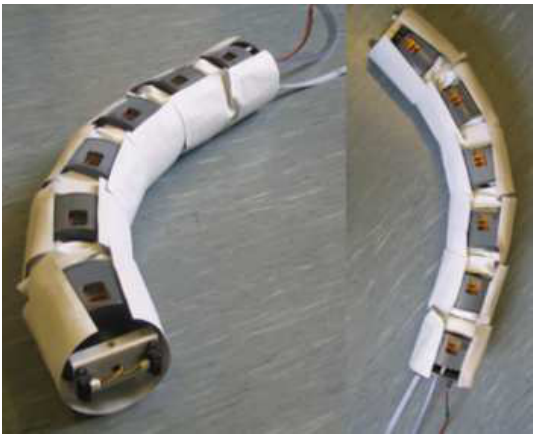
Figure 6: The implemented snake robot. A PVC fabric is wrapped around the snake body in order to cover up the force sensors mounted along the body. These sensors are so-called force sensing resis- tors (FSR), allowing the snake to respond to external